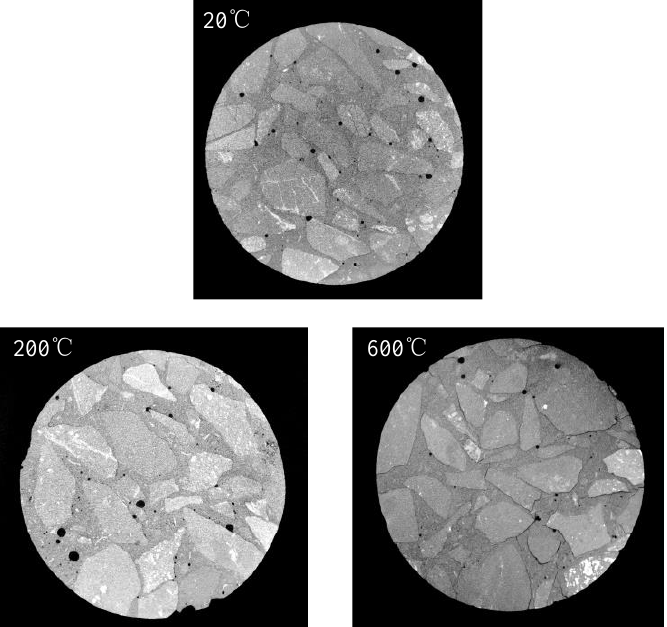
Figure 18. Microscopic morphology of concrete after high temperature and rapid cooling by using CT